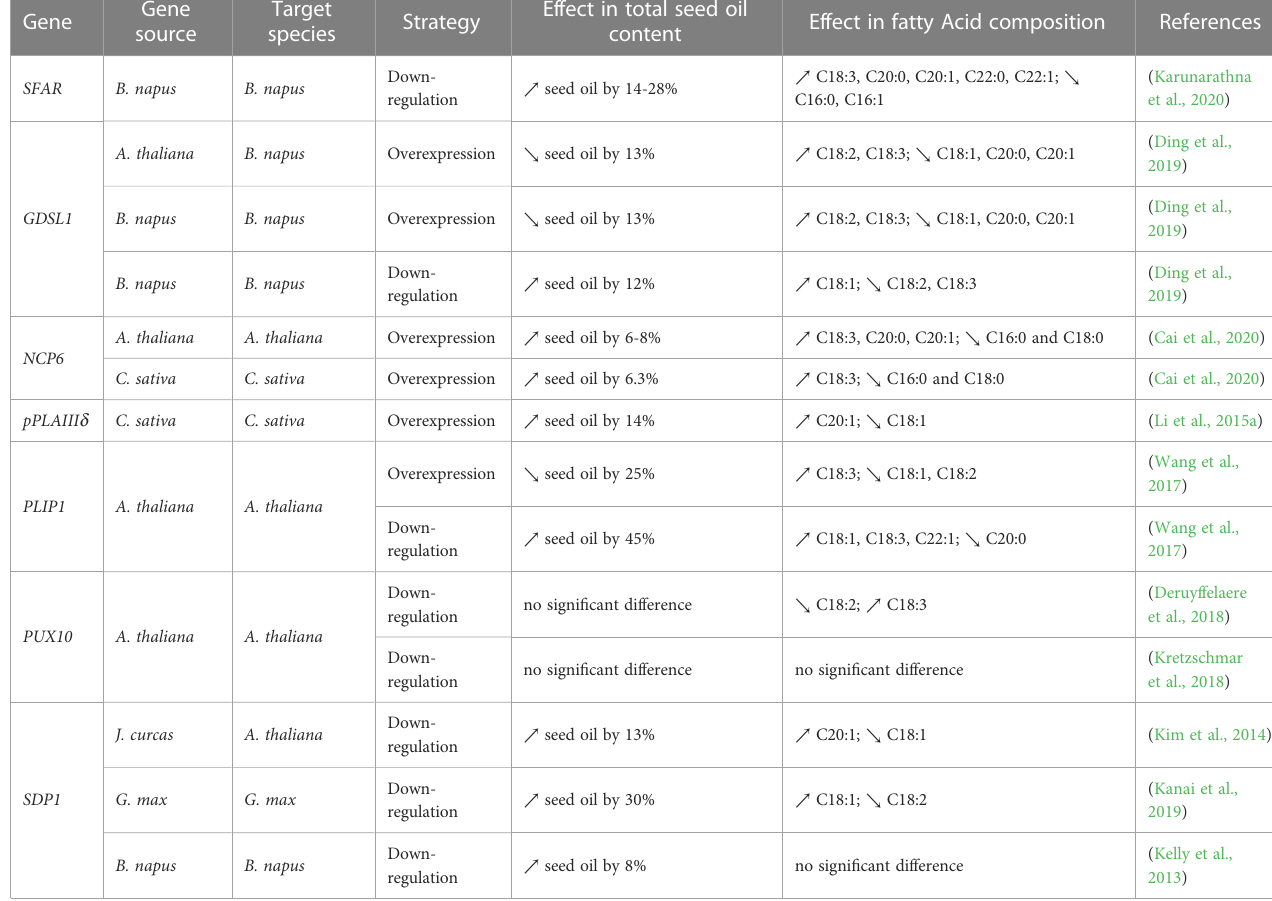
TABLE 7 List of “ protect ” genes used to enhance oil yield and/or change the FA composition in seeds.